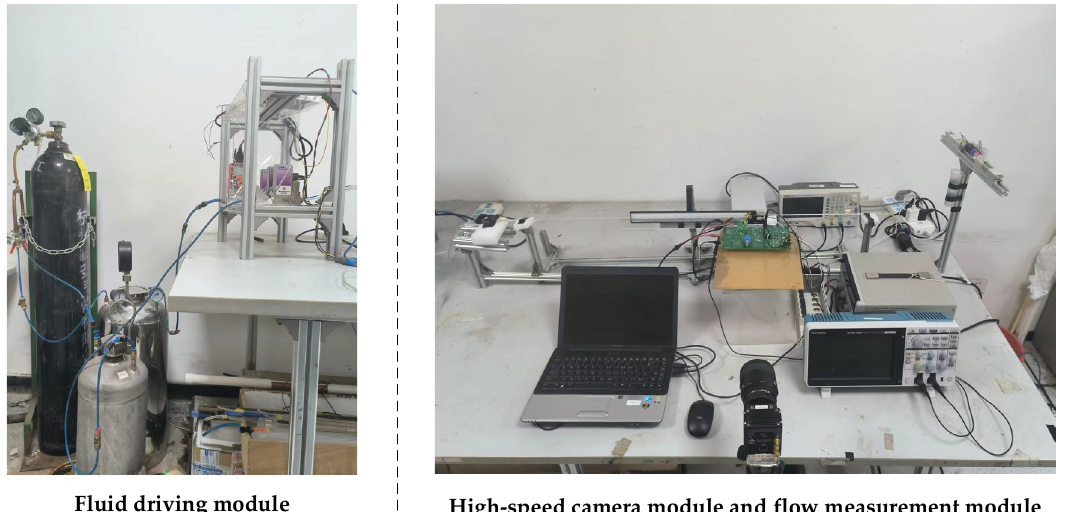
Figure 4. Photograph of the experimental device.